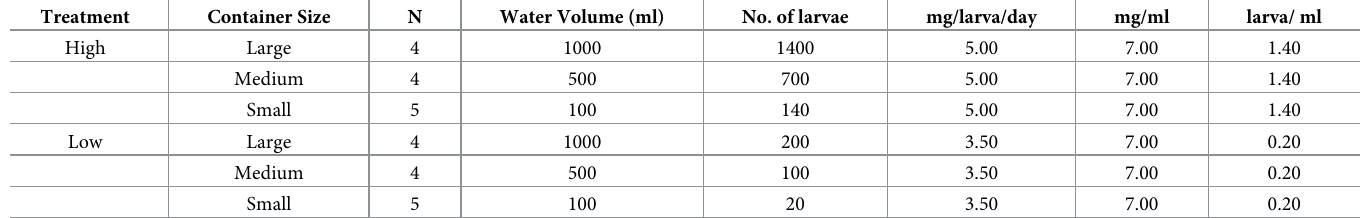
Table 2. Summary of treatment conditions for density experiments. Small (10.00 x 4.20 cm; Diameter x Depth), medium (18.00 x 11.00 x 6.00 cm; Length x Width x Depth) and large (27.00 x 20.70 x 11.00 cm; Length x Width x Depth). Treatment